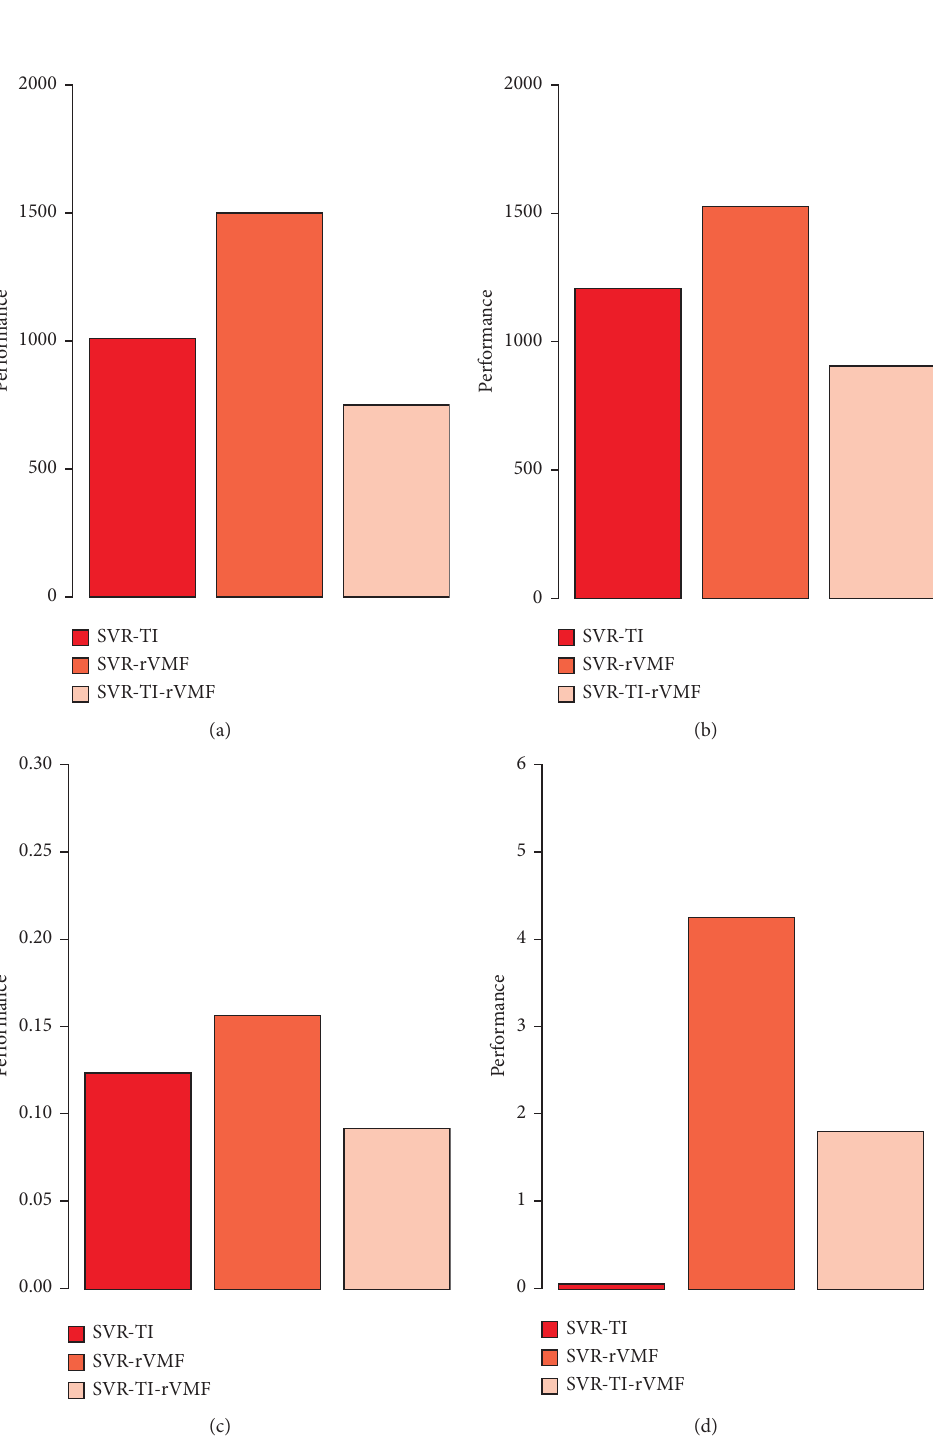
Figure 13: Bar chart of MAE, RMSE, NMRSE, and MAPE of actual and predicted intraday Bitcoin price by SVR-TI, SVR-rVMF, and SVR- TI-rVMF using testing data. (a) MAE. (b) RMSE. (c) NMRSE. (d)